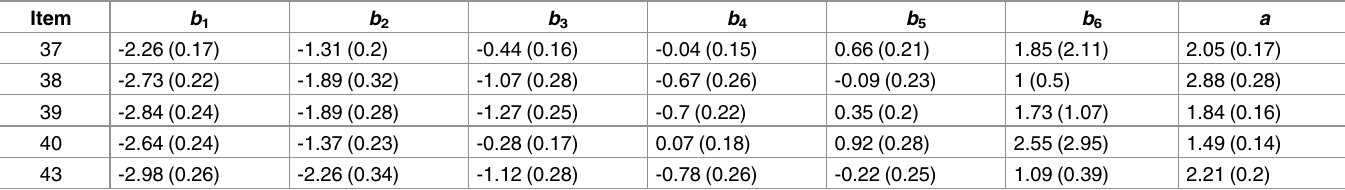
Table 5. Intellectual humility–Corrigibility item parameter estimates.